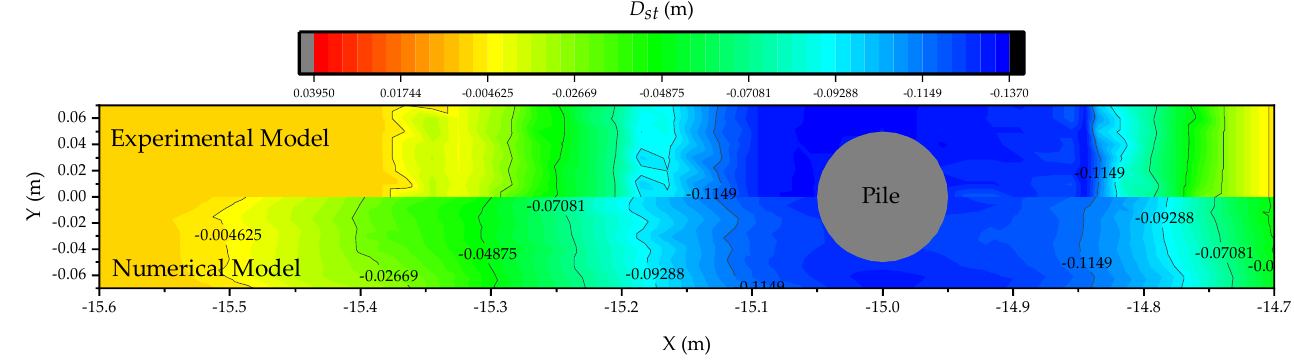
Figure 7. The comparison of the final topography in the numerical models and experimental model.